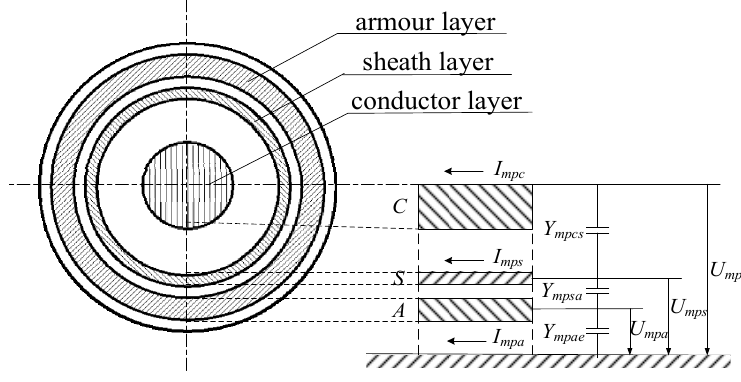
Figure 2. The cross section of positive cable terminal.